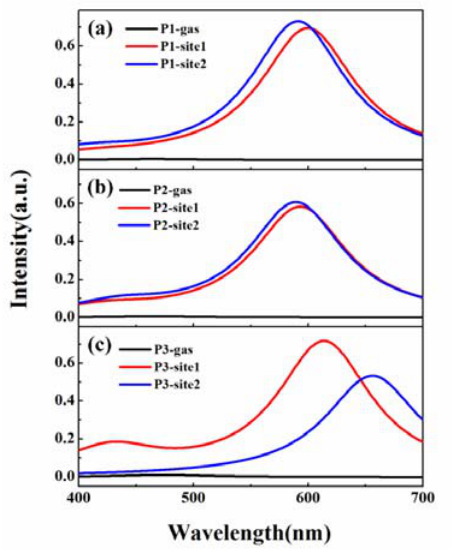
Figure 6. One ‐ photon emission (OPE) spectra for ( a ) P1, ( b ) P2, and ( c ) P3 in different